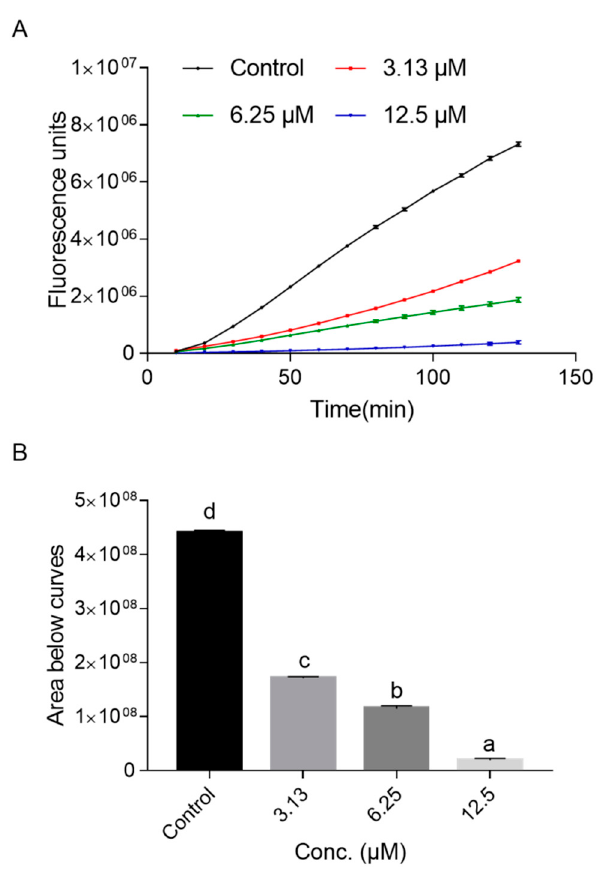
Figure 7. Inhibition of ROS production in C. elegans. The fluorescence curves against measuring time shown ( A ) were plotted from three independent trails, and the fluorescence protection area of NOB was shown according to the area under the curve (AUC) of the NOB treatment group and blank group ( B ).